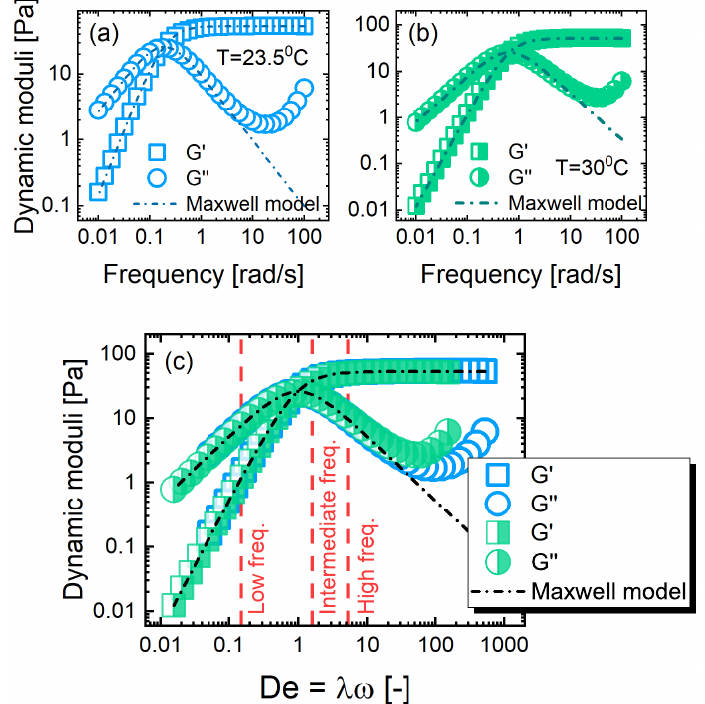
Figure 3. Linear viscoelastic responses. The frequency dependence of dynamic moduli G (cid:48) ( ω ) and G (cid:48)(cid:48) ( ω ) from the polymer-like micelles (PLMs) at 23.5 ◦ C ( a ) and 30 ◦ C ( b ), where the dashed line represents a fit from single-mode Maxwell model. ( c ) The dynamic moduli are collectively plotted against their normalized frequencies De = λω . The three distinct investigated LAOS frequencies are labeled, corresponding to the terminal, rubbery-to-terminal and rubbery–plateau